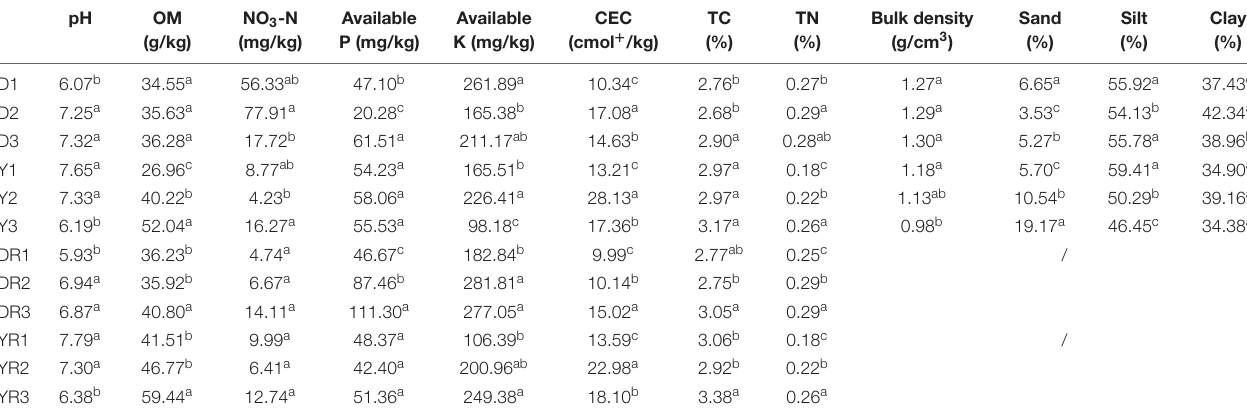
TABLE 1 | The physicochemical properties in the topsoil and rhizosphere soil from Dali and Yuxi. pH OM NO 3 -N Available (g/kg) (mg/kg) P (mg/kg)